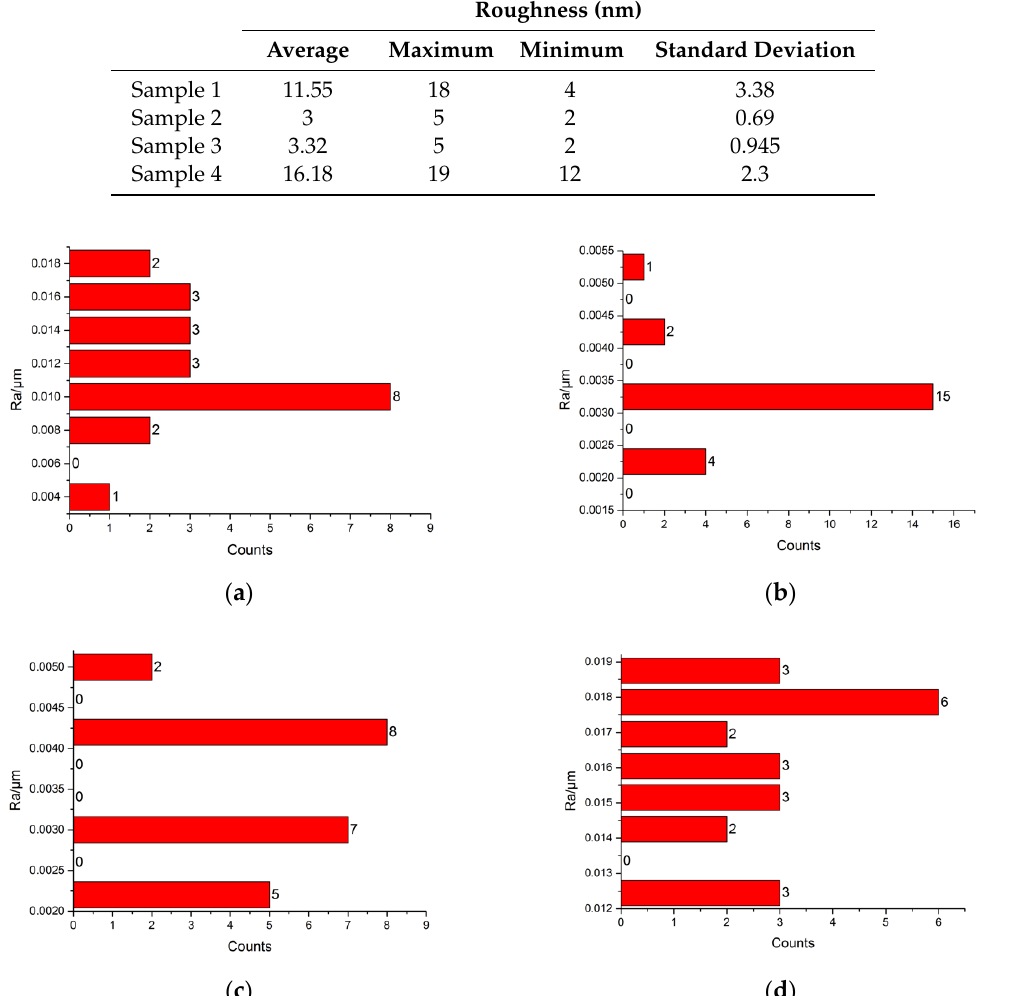
Figure 9. Roughness distribution. ( a ) sample 1; ( b ) sample 2; ( c ) sample 3; and ( d ) sample 4.